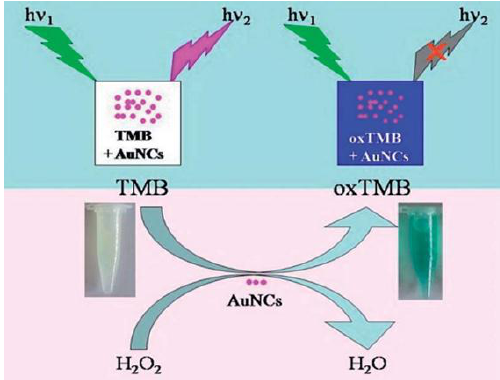
Figure 3. Schematic diagram of detection of H 2 O 2 using the peroxidase-like activity of AuNPs. Reproduced from [14] with permission of The Royal Society of